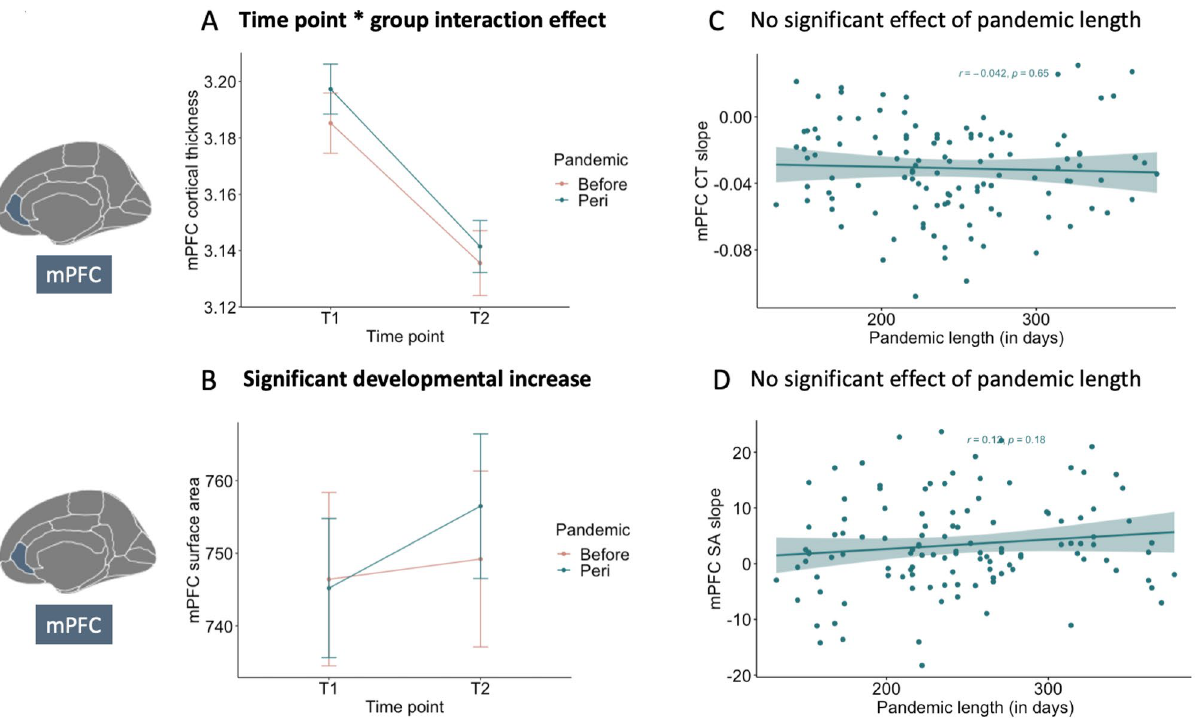
Figure 3. Visualizations of the linear mixed model results of mPFC thickness and surface area development. In ( A ) mPFC cortical thickness is presented on the y-axis and time point on the x-axis. Note that the peri - pandemic group showed accelerated decrease of development. In ( B ) mPFC surface area is presented on the y-axis and time point on the x-axis, showing a significant developmental increase independent of pandemic group. In ( C ) slopes of mPFC thickness of participants in the peri -pandemic group are presented on the y-axis and pandemic length (in days) on the x-axis, showing no association. In ( D ) slopes of mPFC surface area of participants in the peri -pandemic group are presented on the y-axis and pandemic length (in days) on the x-axis, showing no association. mPFC = medial prefrontal cortex; CT cortical thickness, SA surface